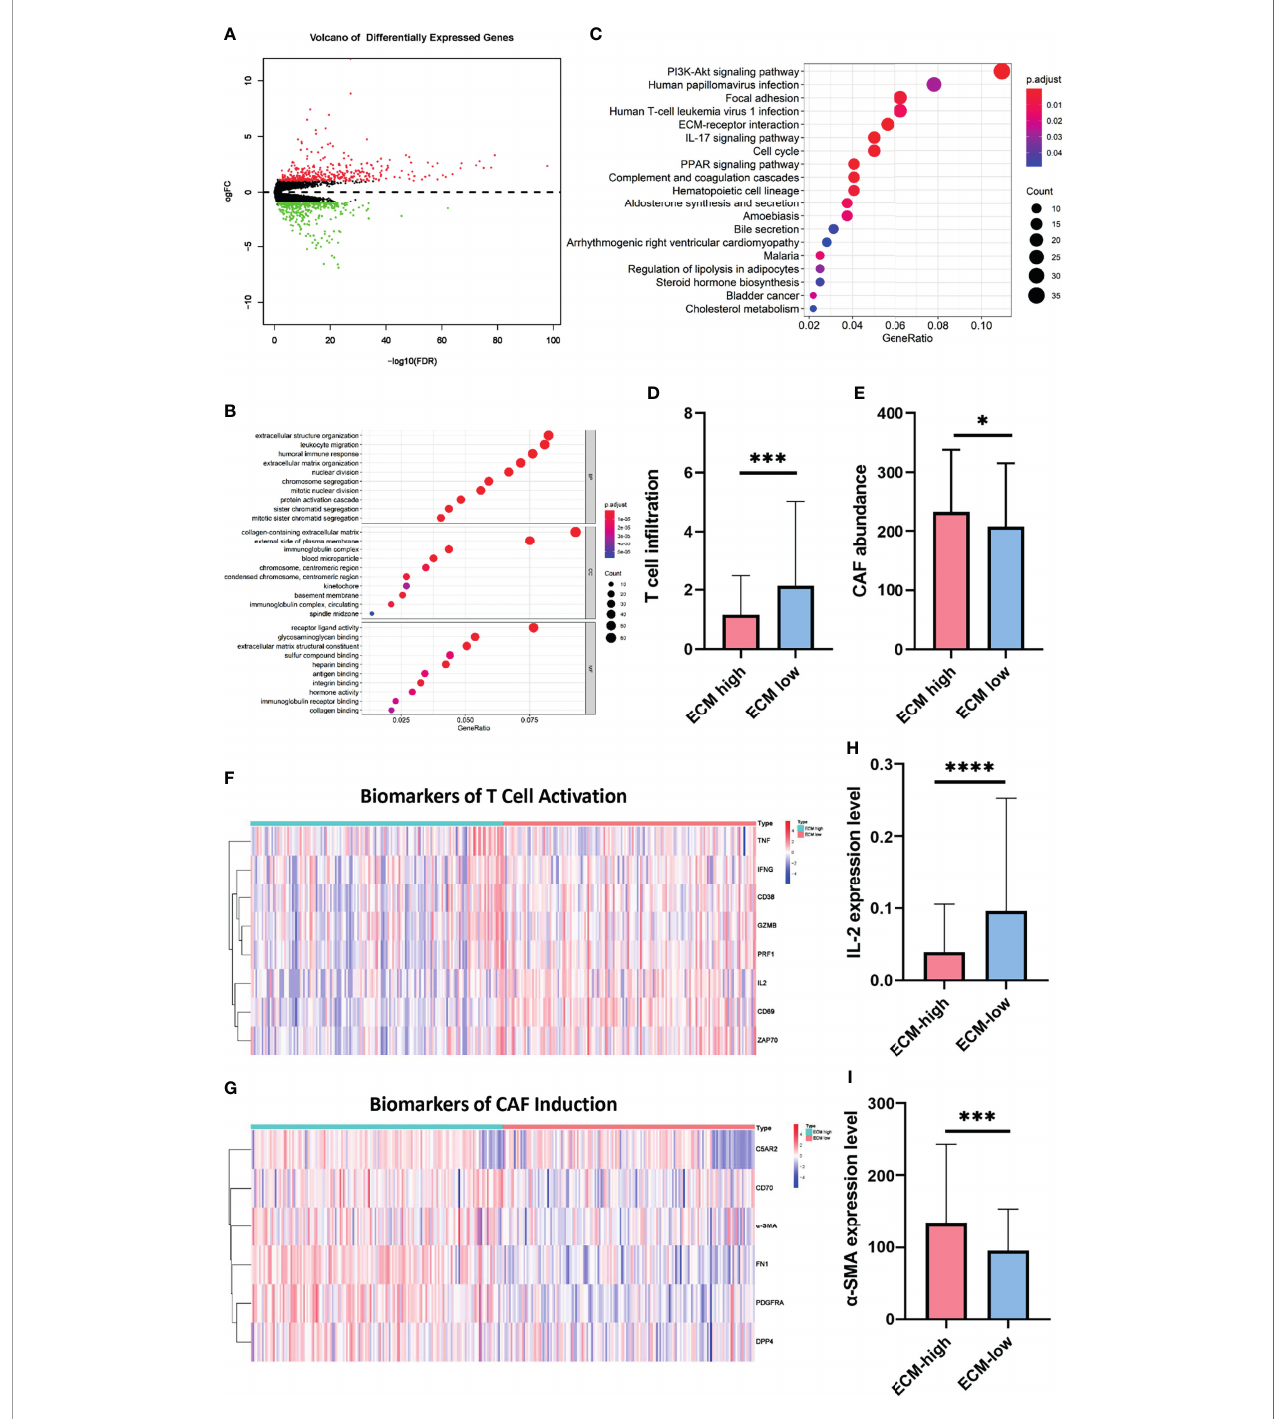
FIGURE 4 | C-ECM dysregulation is associated with T cell and CAF activities. (A) Volcano plot of differentially expressed genes across ECM-high and ECM-low groups. (B) Results of KEGG analyses across different ECM score groups. (C) Results of GO analyses between different ECM score groups into three functional groups, including biological process (BP), cellular component (CC) and molecular function (MF). (D) T cell in fi ltration of ECM-high and ECM-low groups conducted by TIMER. (E) Abundance of CAFs of ECM-high and ECM-low groups conducted by TIMER. (F) The heatmap of T cell activation biomarkers of ECM-high and ECM-low groups. (G) The heatmap of CAF induction biomarkers of ECM-high and ECM-low groups. (H) The IL-2 expression level of ECM-high and ECM-low groups. (I) The a -SMA expression level of ECM-high and ECM-low groups. * P < 0.05; *** P < 0.001, **** P <